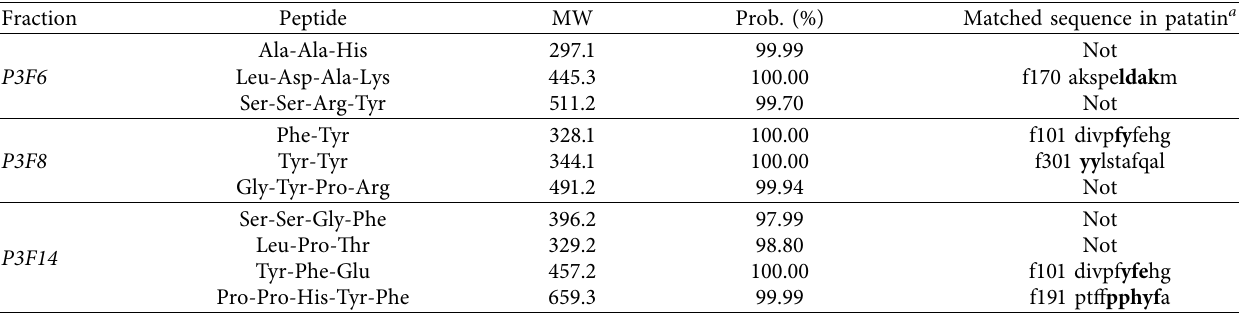
Ser-Ser-Gly-Phe 396.2 97.99 Not P3F14